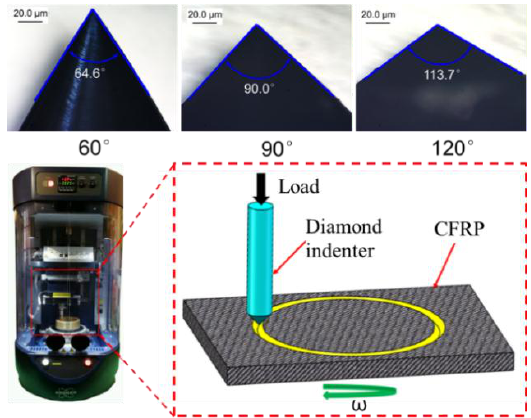
Figure 13. Schematic diagram of scratching CFRP composites with diamond indenter.